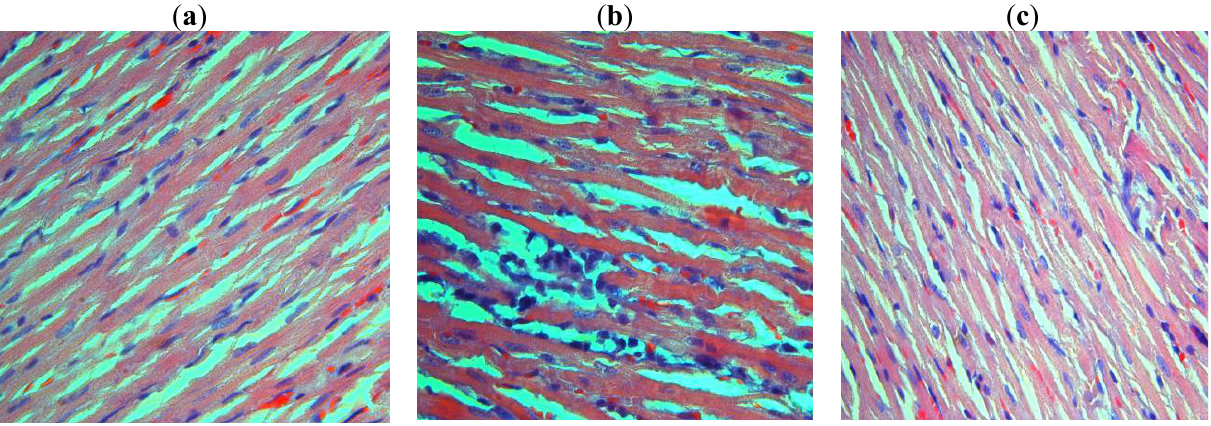
Figure 5. Histopathological changes in the myocardium at three groups. ( a ) The sham group, with a well-arranged cardiac cells and integrated membrane. ( b ) The IR group, showing swelling myocardial cells, a disordered striated cardiac muscle, and local myocardial necrosis. A great number of erythrocytes are present and local infiltration of inflammatory cells is observed. ( c ) The IR + ulinastatin group, showing a well-arranged cardiac cells and a tiny amount of neutrophil